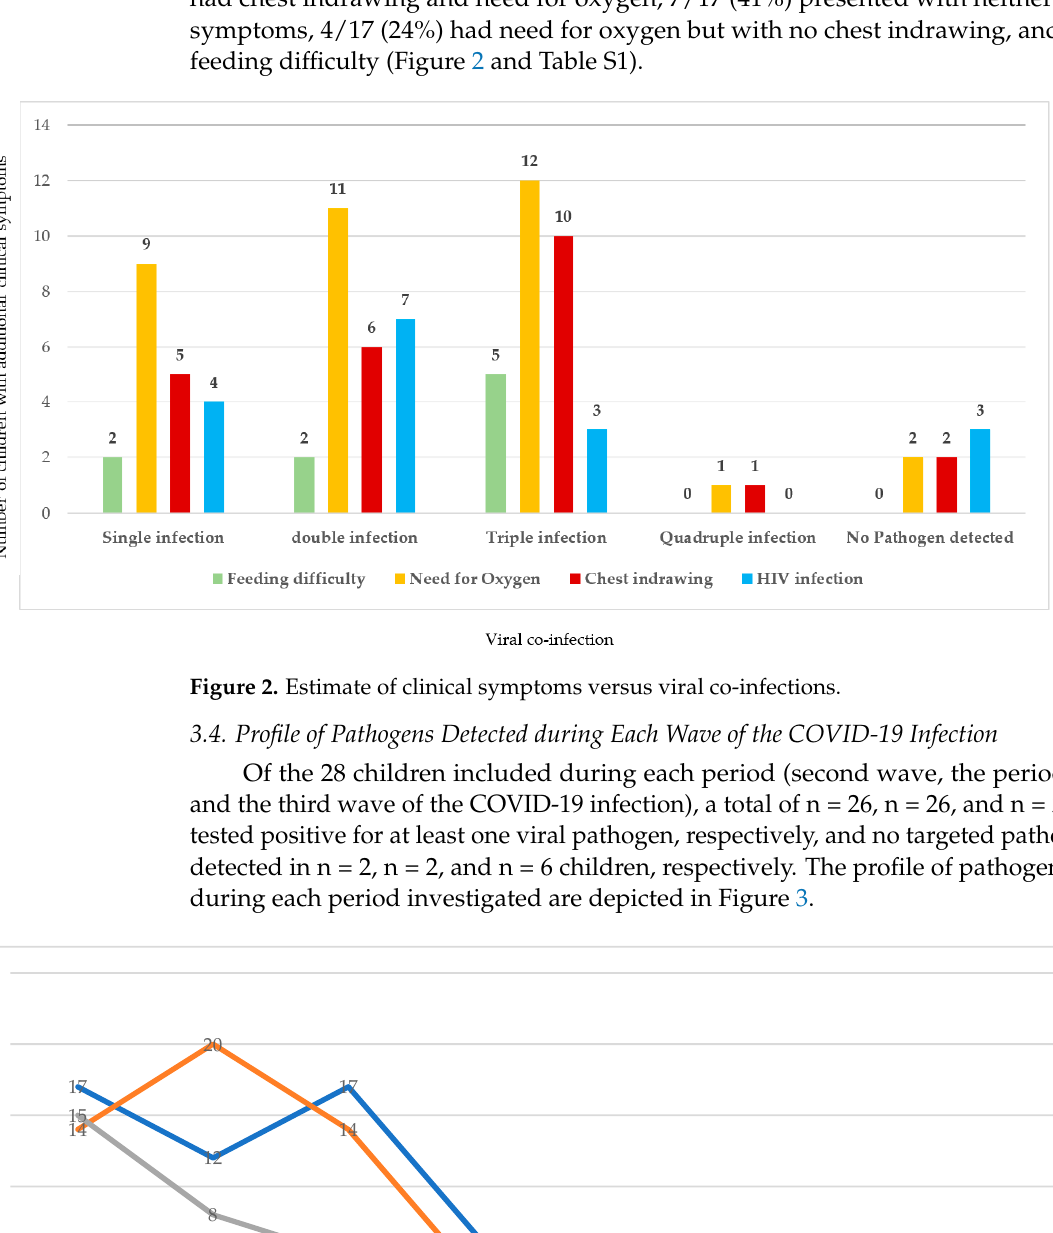
triple viral co-infection, respectively. Moreover, none presented with quadruple infection and 3/17 (18%) had no pathogen detected. In addition, 6/17 (35%) children with HIV had chest indrawing and need for oxygen, 7/17 (41%) presented with neither of the two symptoms, 4/17 (24%) had need for oxygen but with no chest indrawing, and none had feeding difficulty (Figure 2 and Table S1).